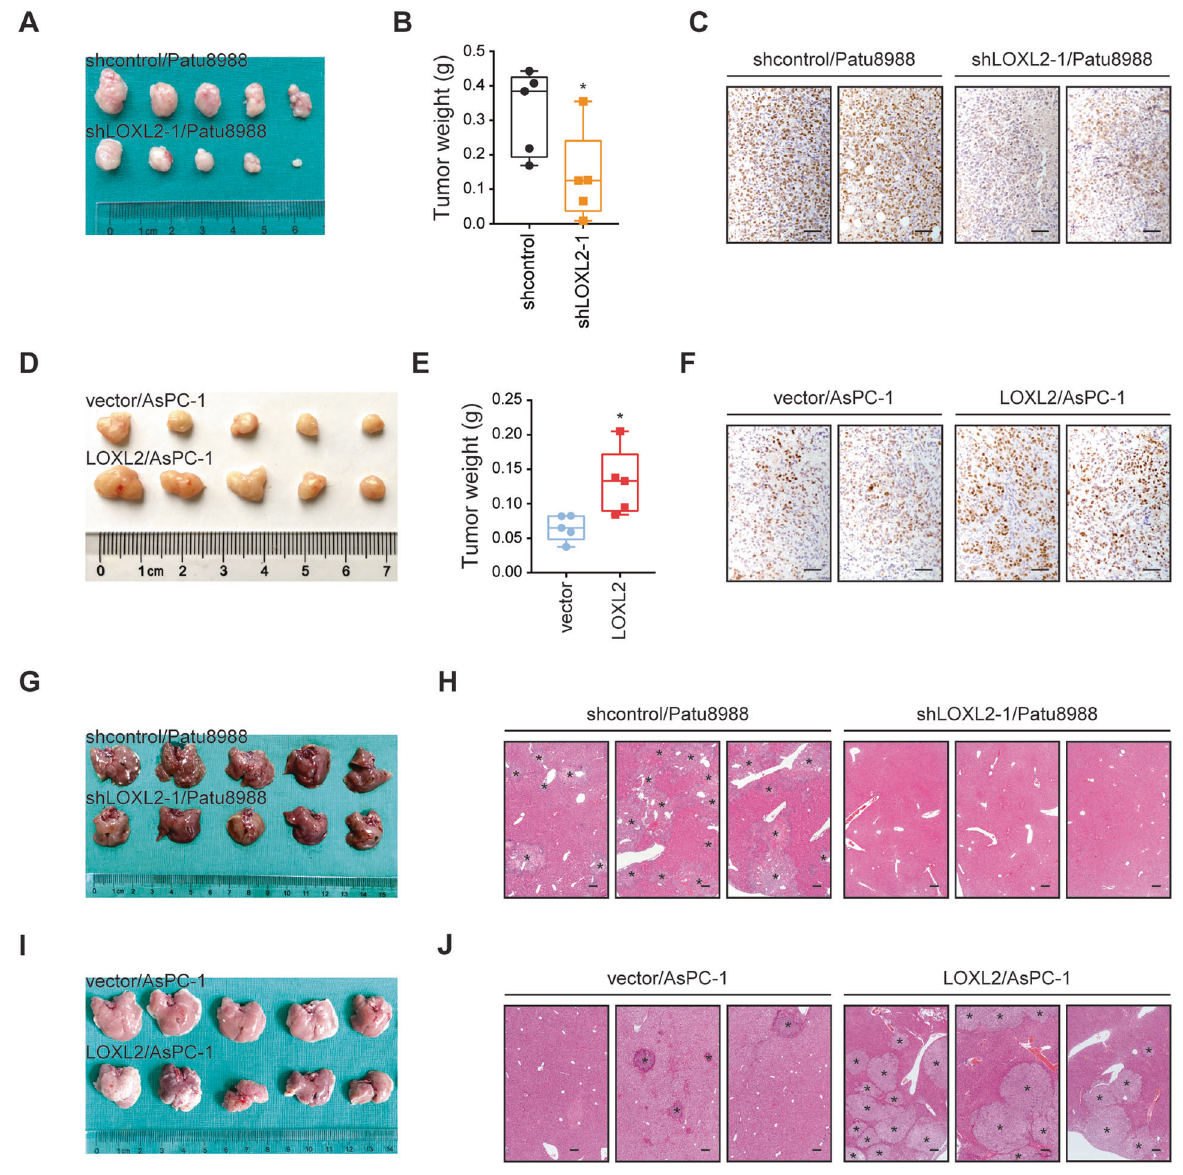
Fig. 4 LOXL2 facilitates tumor growth and liver metastasis of PDAC in vivo. A Growth of subcutaneous xenografts from LOXL2 knockdown and control Patu8988 cells. B Weight of primary subcutaneous tumors of mice in ( A ). C Representative IHC images of PCNA staining in LOXL2 knockdown and control subcutaneous xenograft tissues. Scale bar: 50 μ m. D Growth of subcutaneous xenografts from LOXL2-overexpressing and vector control AsPC-1 cells. E Weight of primary subcutaneous tumors of mice in ( D ). F Representative IHC images of PCNA staining in LOXL2-overexpressing and vector control subcutaneous xenograft tissues. Scale bar: 50 μ m. ( G ) Liver metastasis of intrasplenic xenografts from LOXL2 knockdown and control Patu8988 cells. H Representative hematoxylin and eosin (H&E) images of liver metastasis in ( G ). The asterisks indicate liver metastasis lesions. Scale bar: 200 μ m. I Liver metastasis of intrasplenic xenografts from LOXL2-overexpressing and vector control AsPC-1 cells. J Representative H&E images of liver metastasis in ( I ). The asterisks indicate liver metastasis lesions. Scale bar: 200 μ m. * p <